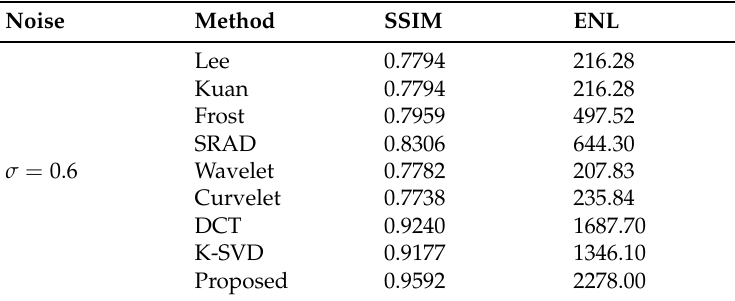
Table 2. The objective evaluation values of denoising results.